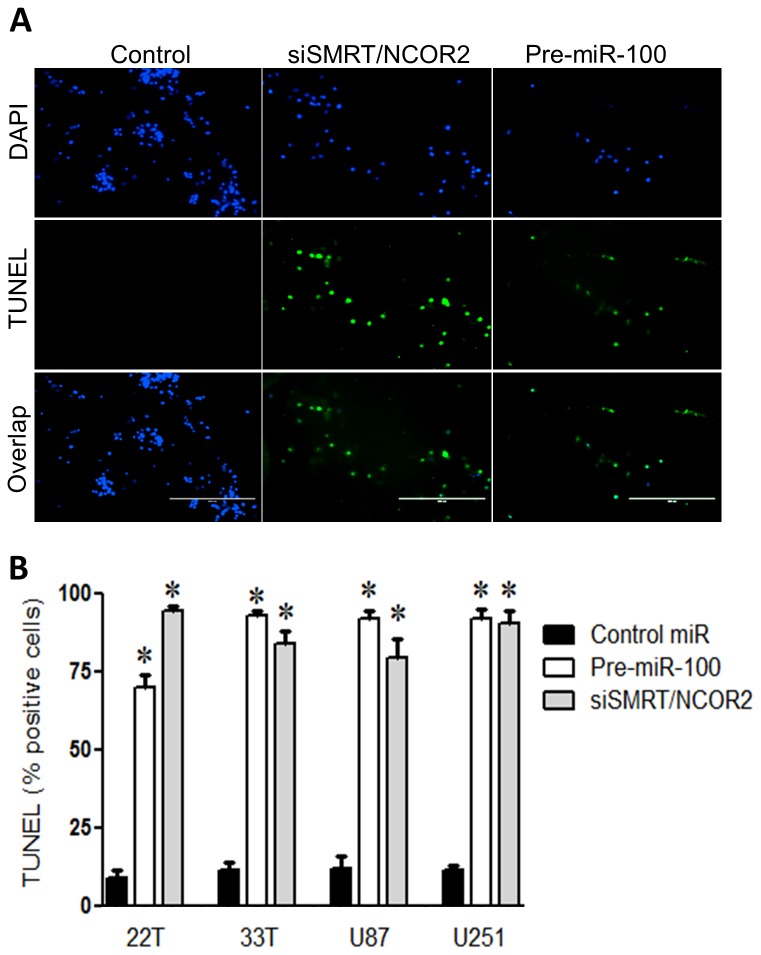
miR-100 induces cell death(A) Treatment with either pre-miR-100 or SMRT/NCOR2 siRNA (siSMRT/NCOR2) induced cell death as shown by TUNEL staining. The control cells were treated with control miR (ـــ) Scale bar, 200 um. (B) Quantitative analysis show marked increase of TUNEL-positive cells in GBMs transfected with either siSMRT/NCOR2 or pre-miR-100 compared control miR treated group.